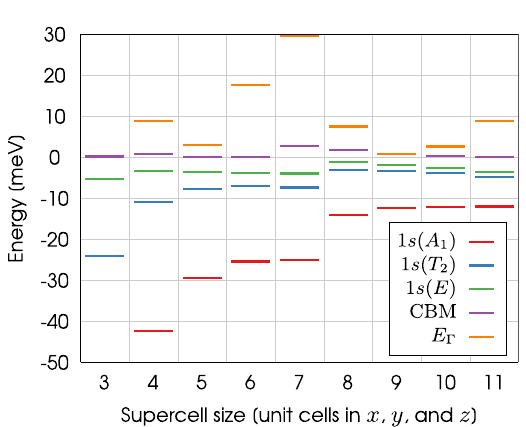
Figure 4. ( a ) The lowest conduction valley of bulk silicon for simple cubic supercells that range in size from 8 to 4096 atoms. The key shows the dimensions of the supercells in terms of the number of simple cubic unit cells in x , y , and z , i.e. 8 is equivalent to 8 × 8 × 8 unit cells or 4096 atoms. The boundaries of the Brillouin zones for each of the supercells are shown as vertical lines. The CBM of bulk silicon has been set to energy zero. ( b ) The difference between the energy of the conduction valley at the Γ point ( Γ E ) and the CBM for supercells that range in size from 8 to 10,648 atoms.